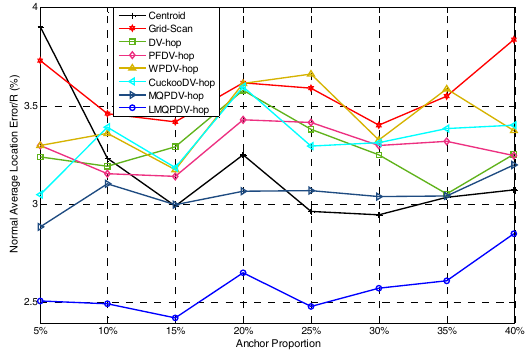
Figure 10. Communication range 150 for WSN#2.